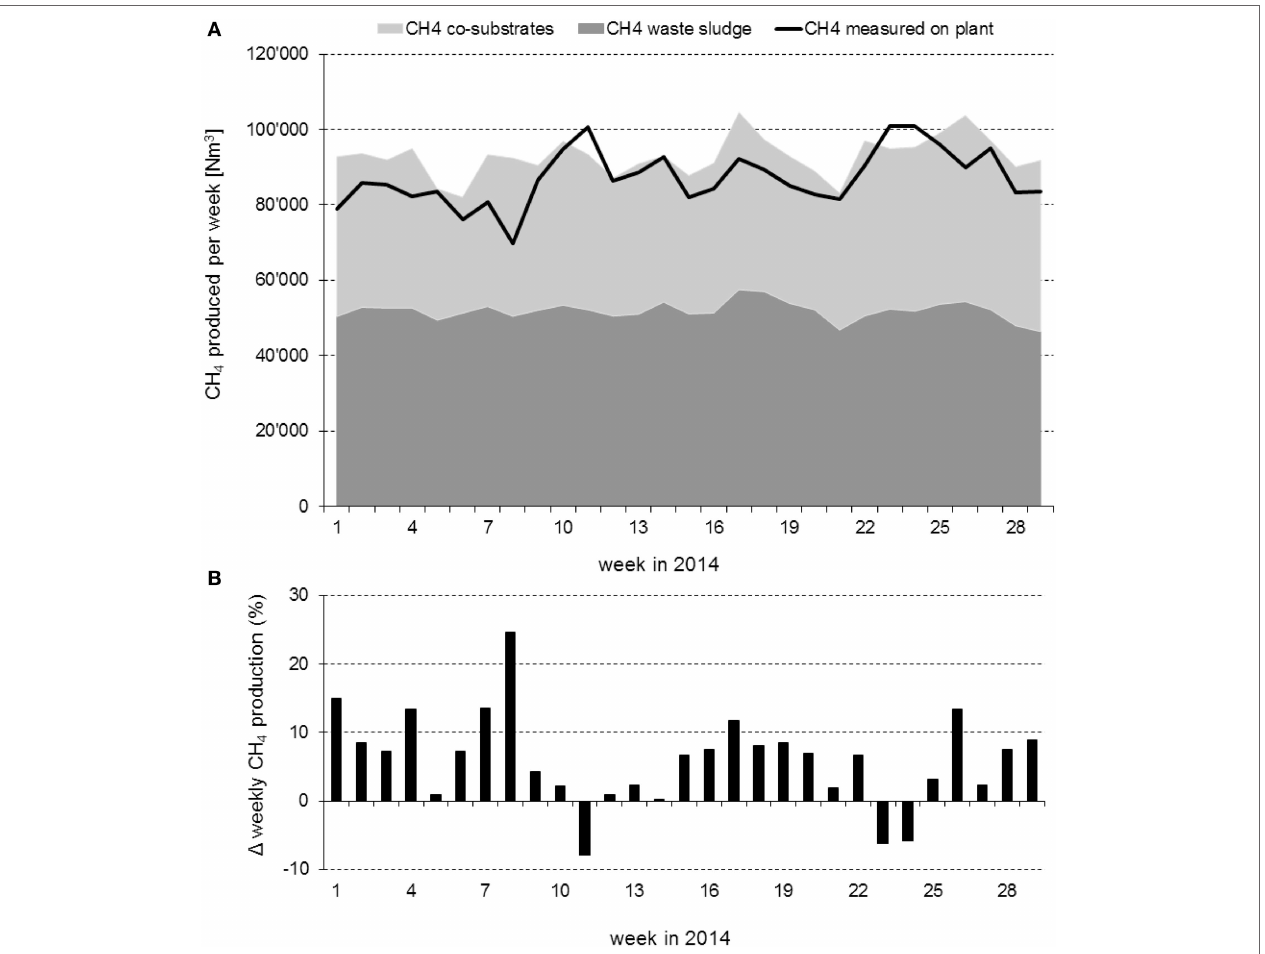
FigUre 1 | Weekly methane production at the wet anaerobic digestion plant over a period of 29 weeks. (a) Weekly methane production calculated from biomethane potentials of substrates and weekly organic loads (light and dark gray surfaces) and measured at the plant (black line). (B) Relative difference between measured and calculated methane